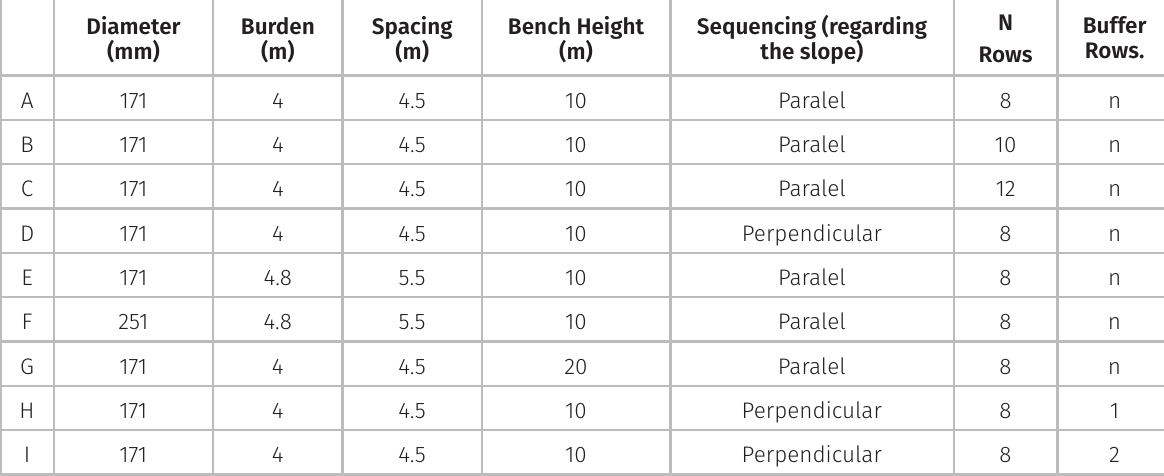
Table V. Blast designs simulated using the model.